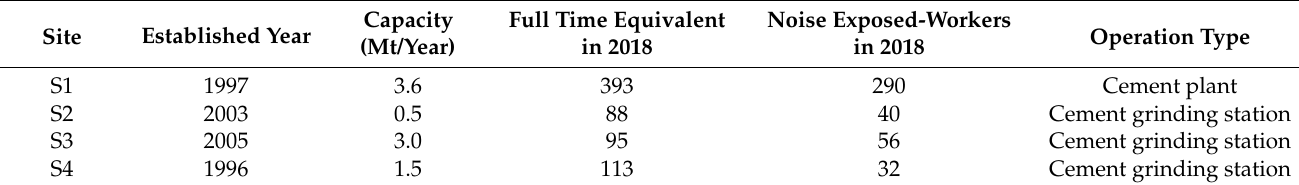
Table 1. The General Information of Study